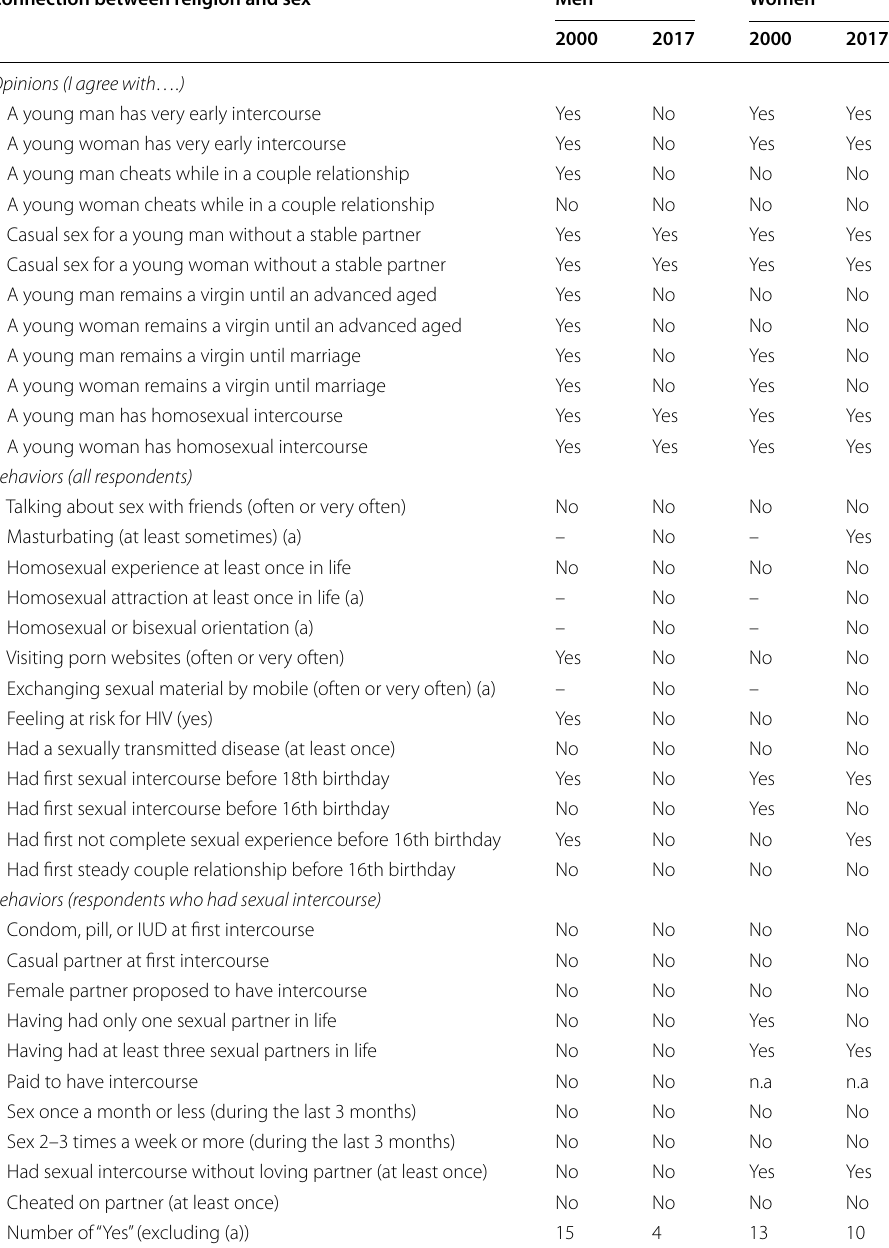
Table 8 Connection between religion and sex (logistic models) by gender and